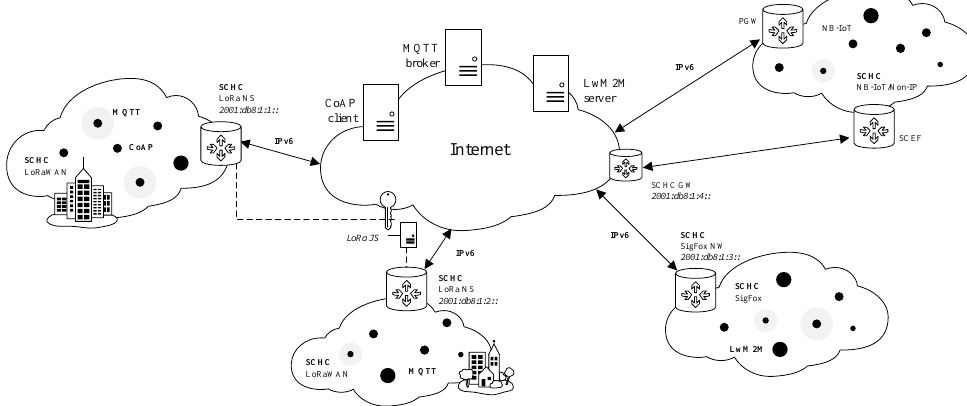
Figure 2. End-to-end secured, decentralized IPv6 Low-Power Wide-Area